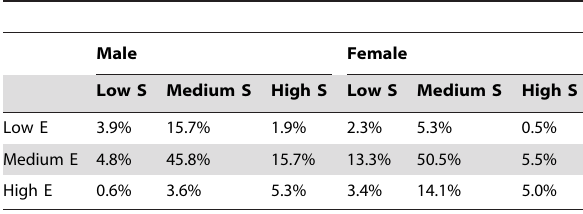
Table 4. The proportion of males and females by the classification scheme shown in the right panel of Figure 2.